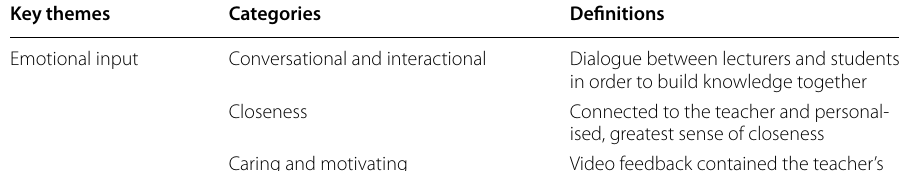
Table 1 Definition of themes, categories and corresponding examples